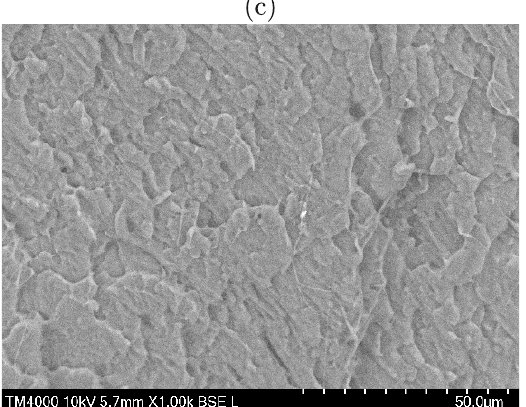
Figure 6. SEM micrographs representing the cross-sectional microstructure of the filament produced with ( a ) vPLA; ( b ) vPLA+PBO; ( c ) rPLA+PBO at a magnification of × 500.